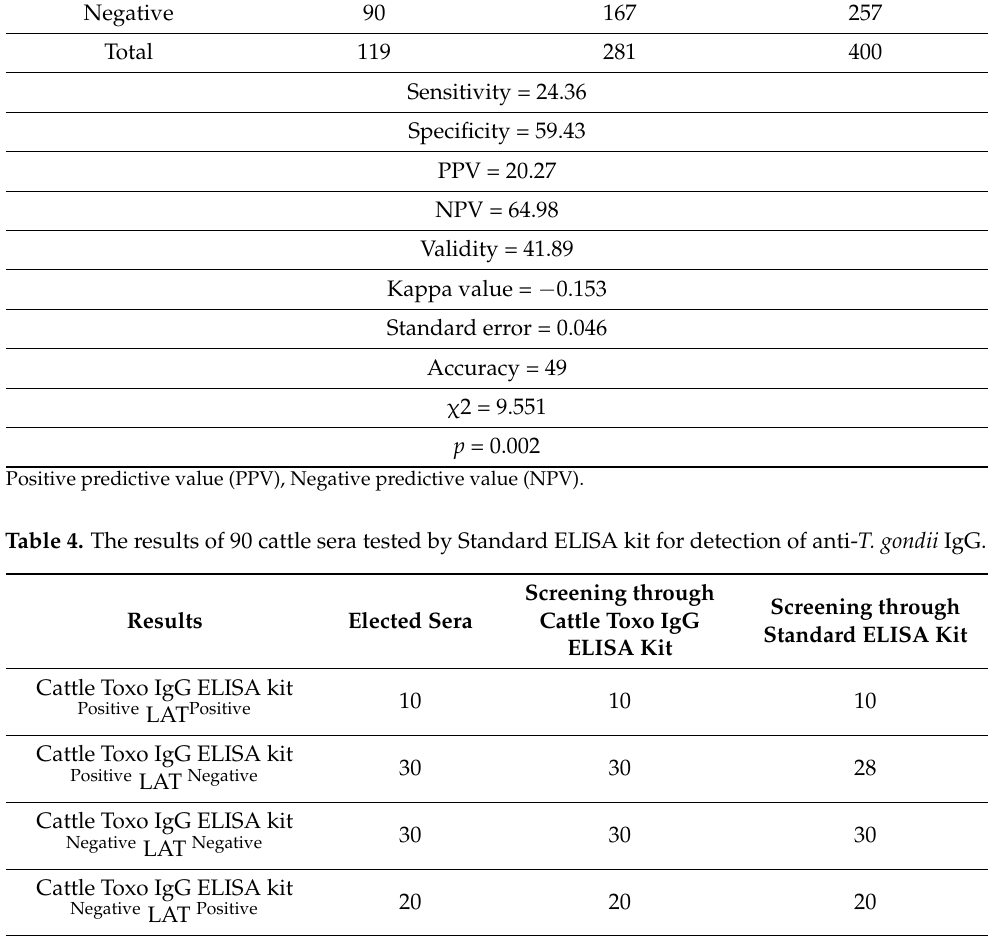
Table 4. The results of 90 cattle sera tested by Standard ELISA kit for detection of anti- T. gondii IgG.